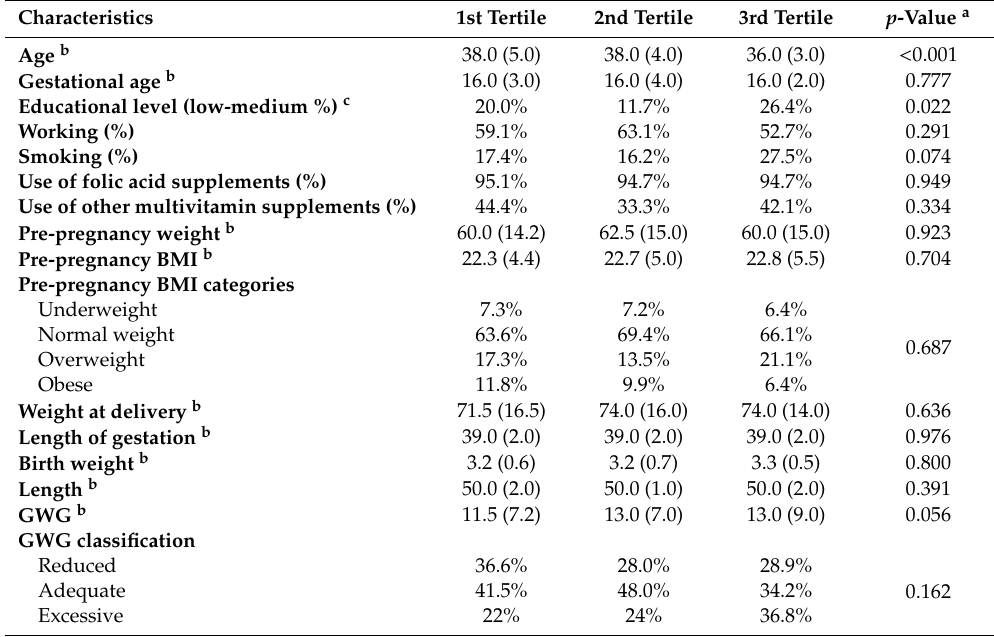
Table 2. Characteristics of women from the “Mamma & Bambino” cohort ( n = 232) according to adherence to the Western dietary